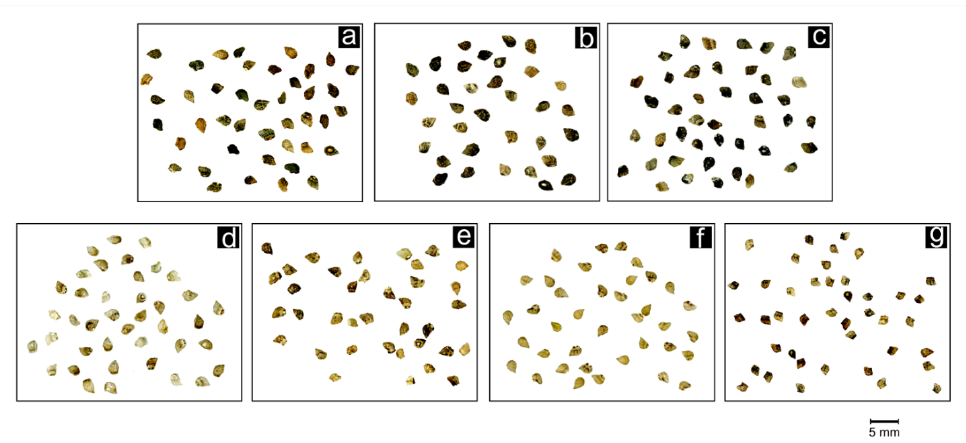
Figure 5. Examples of the seed image scans of the taxa analyzed. ( a ) A. capellii ; ( b ) A. formosa ; ( c ) A. montelinasana ; ( d ) A. crispa ssp. crispa ; ( e ) A. crispa ssp. maritima ; ( f ) A. littorea ; ( g ) A. sardoa